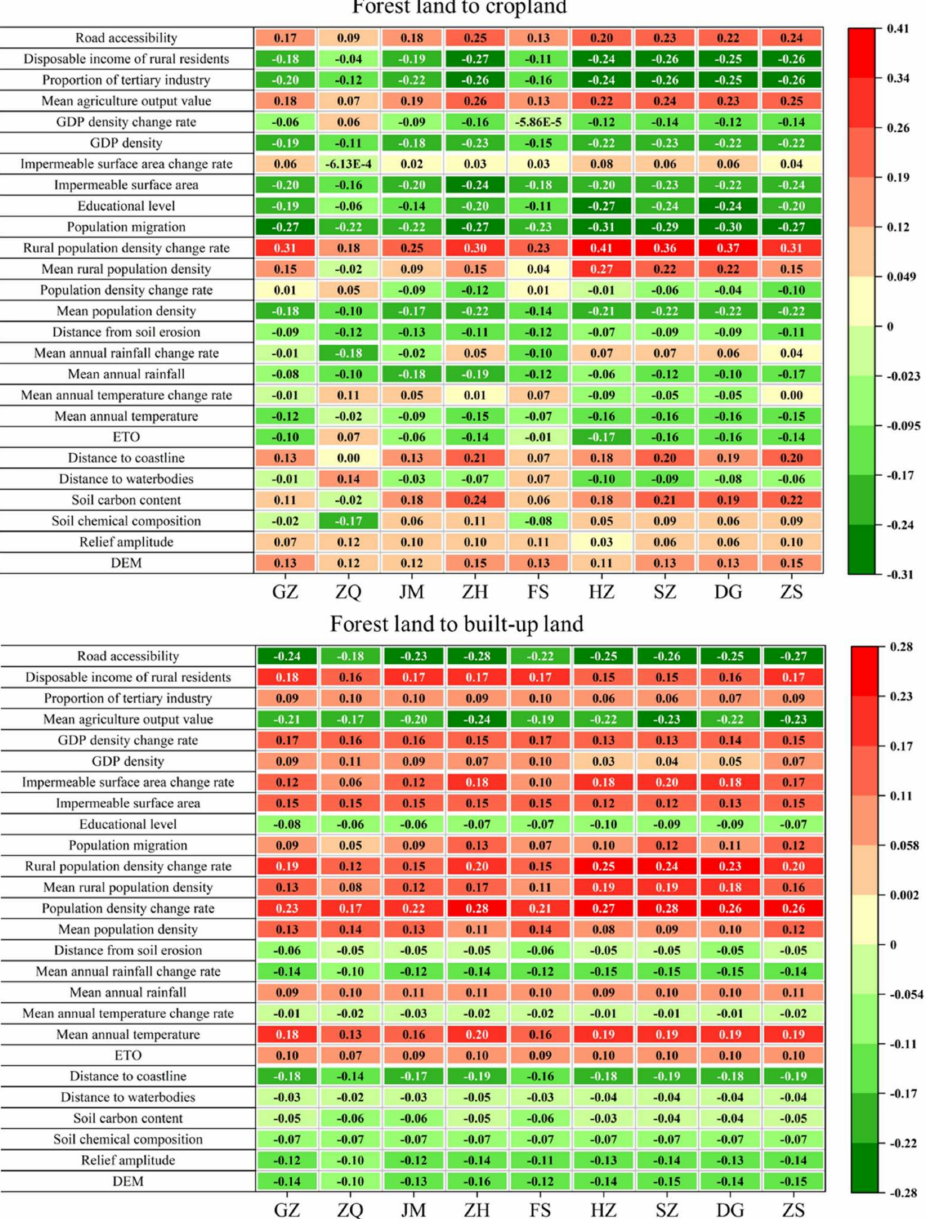
Figure 4. The Geographically weighted regression coefficients of each factor in different cities for deforestation. The numerical value represented the strength of the main force. The redder the color, the stronger the positive effect. The greener the color, the stronger the negative effect. GZ: Guangzhou; SZ: Shenzhen; ZH: Zhuhai; FS: Foshan; JM: Jiangmen; ZQ: Zhaoqing; DG: Dongguan; ZS: Zhongshan; HZ: